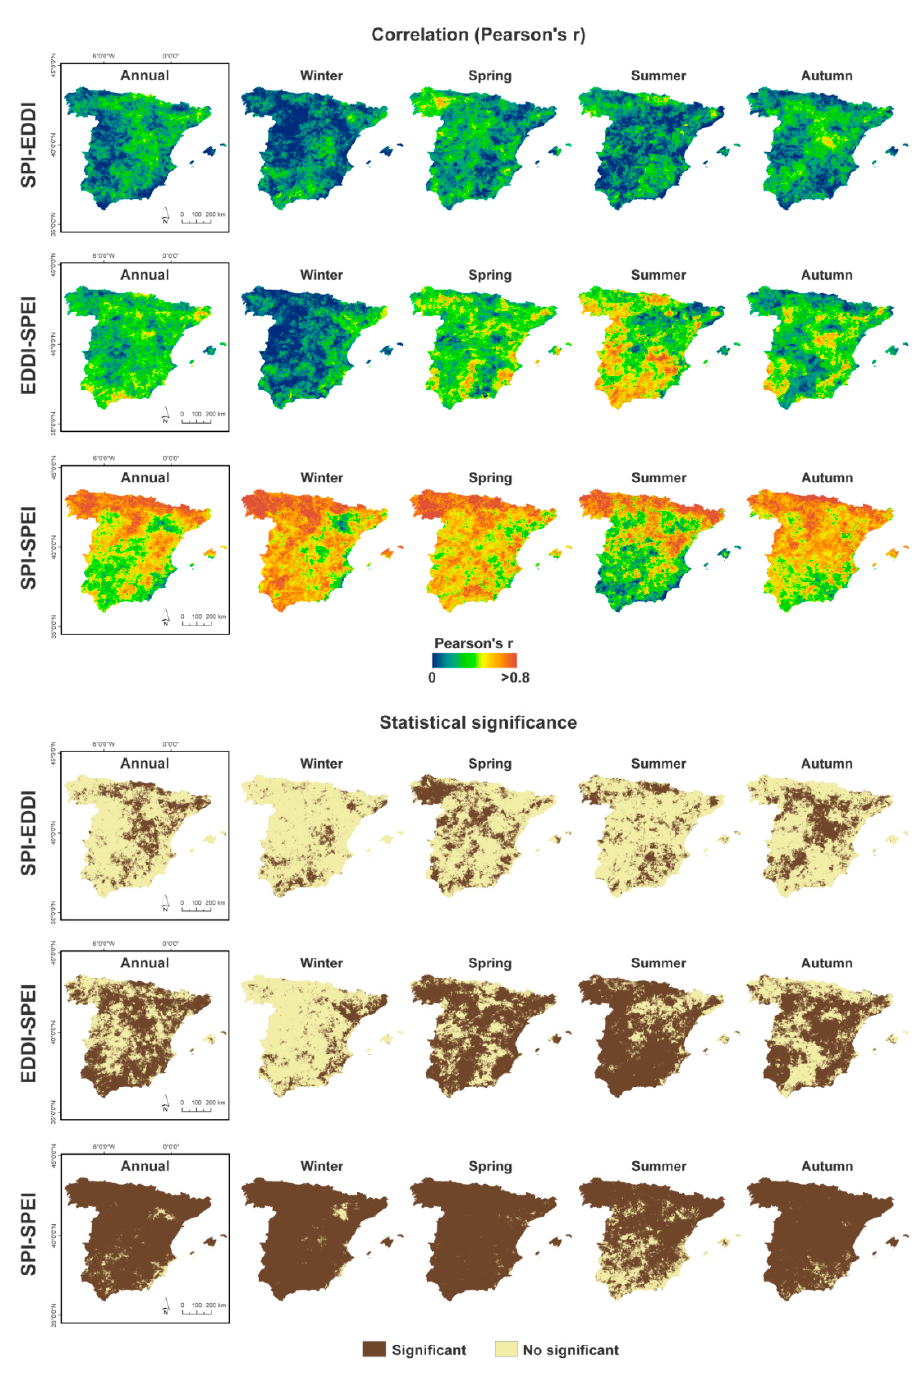
Figure 7. Spatial pattern of the correlation (Pearson’s r) and associated significance between flash drought series identified by the SPI, EDDI, and SPEI over the period 1961–2018 at annual and seasonal